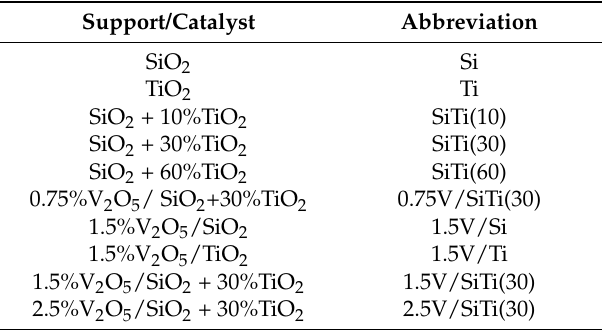
Table 4. Catalysts prepared for the oxidation